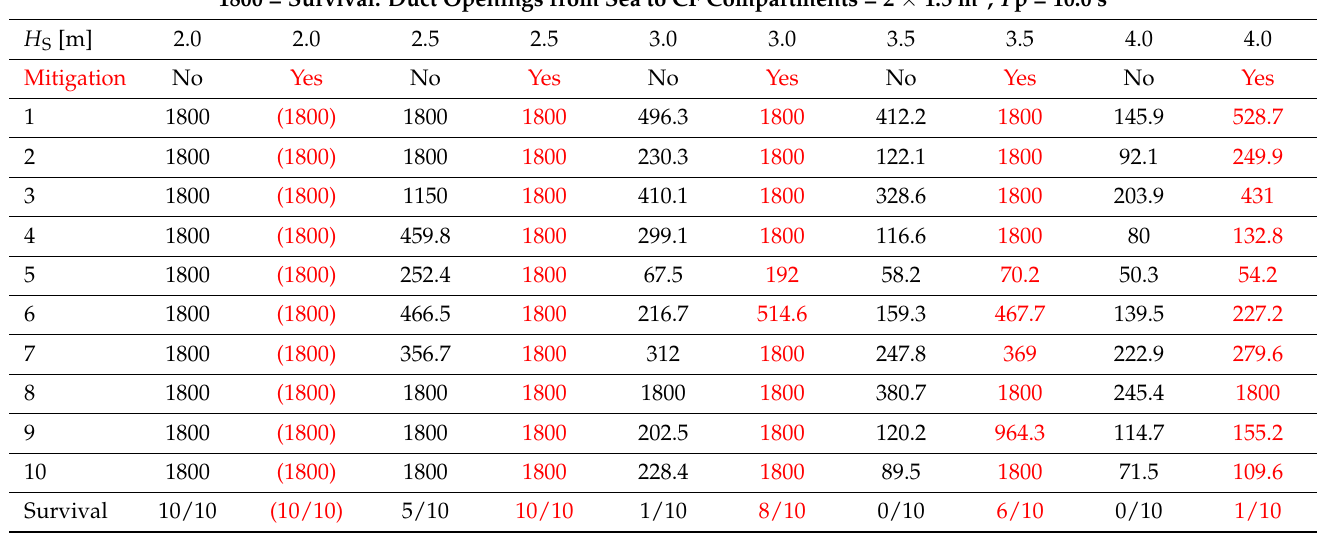
Table 2. Damage Case 2, with (red) and without (black) counter flooding in beam seas. The values in brackets were not explicitly computed, as the result (survival) is